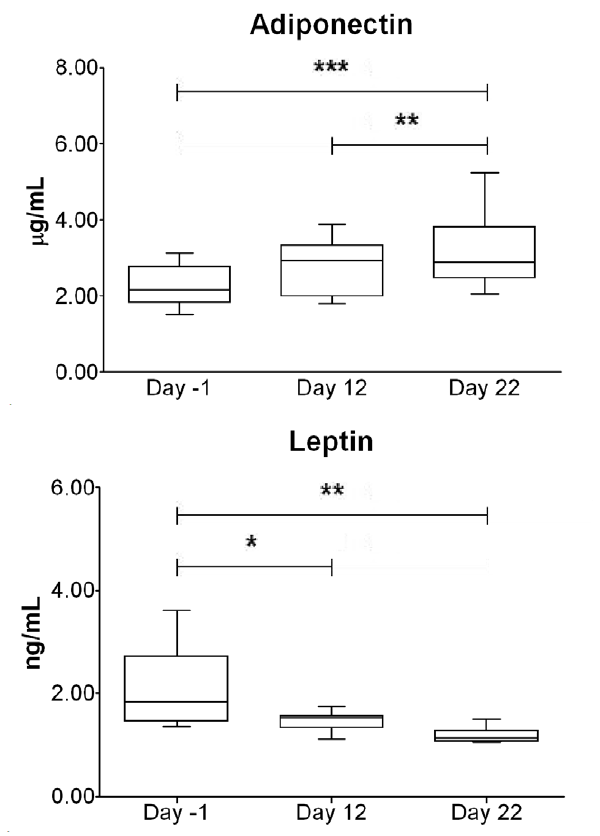
Figure 3. Modification of adipokines levels over the race. The Figure shows the trends of serum adiponectin (panel A) and serum leptin (panel B) over the stage race. ***, ** and * indicate significant variations (p , 0.001, p , 0.01 and p , 0.05,